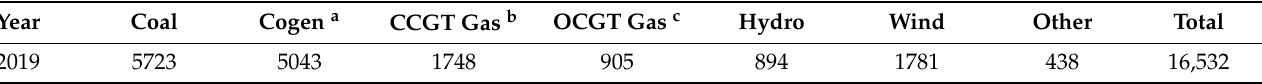
Table 1. Alberta Electric System Generating Capacity in 2019 (MW).